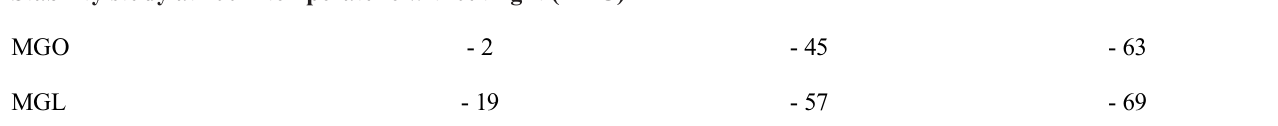
% after % after % after Sample 3 months 6 months 12 months MGL - 4 - 50 N Stability study at room temperature with light (22 o C) MGO + 2 - 46 - 65 MGL - 17 - 51 - 73 Stability study at room temperature without light (22 o C) MGO - 2 - 45 - 63 MGL - 19 - 57 -